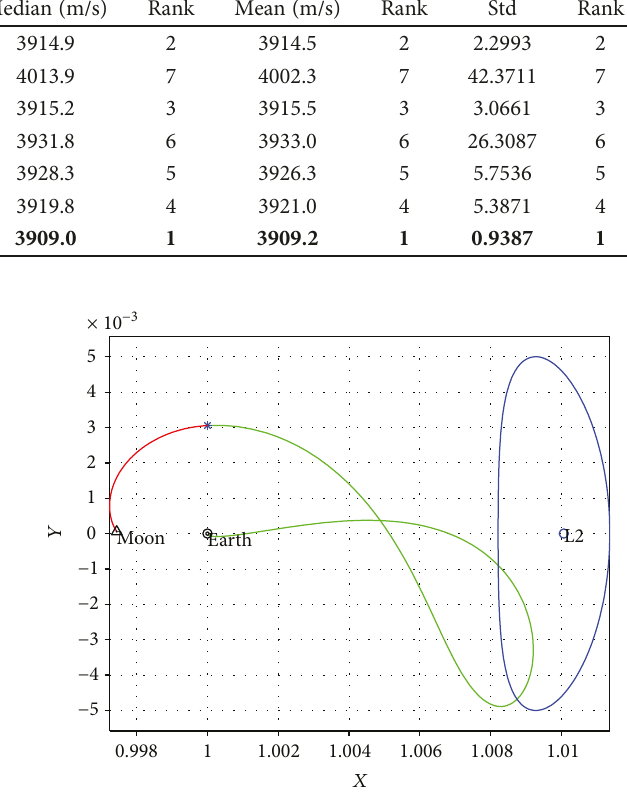
Figure 4: The best Earth-Moon low-energy transfer